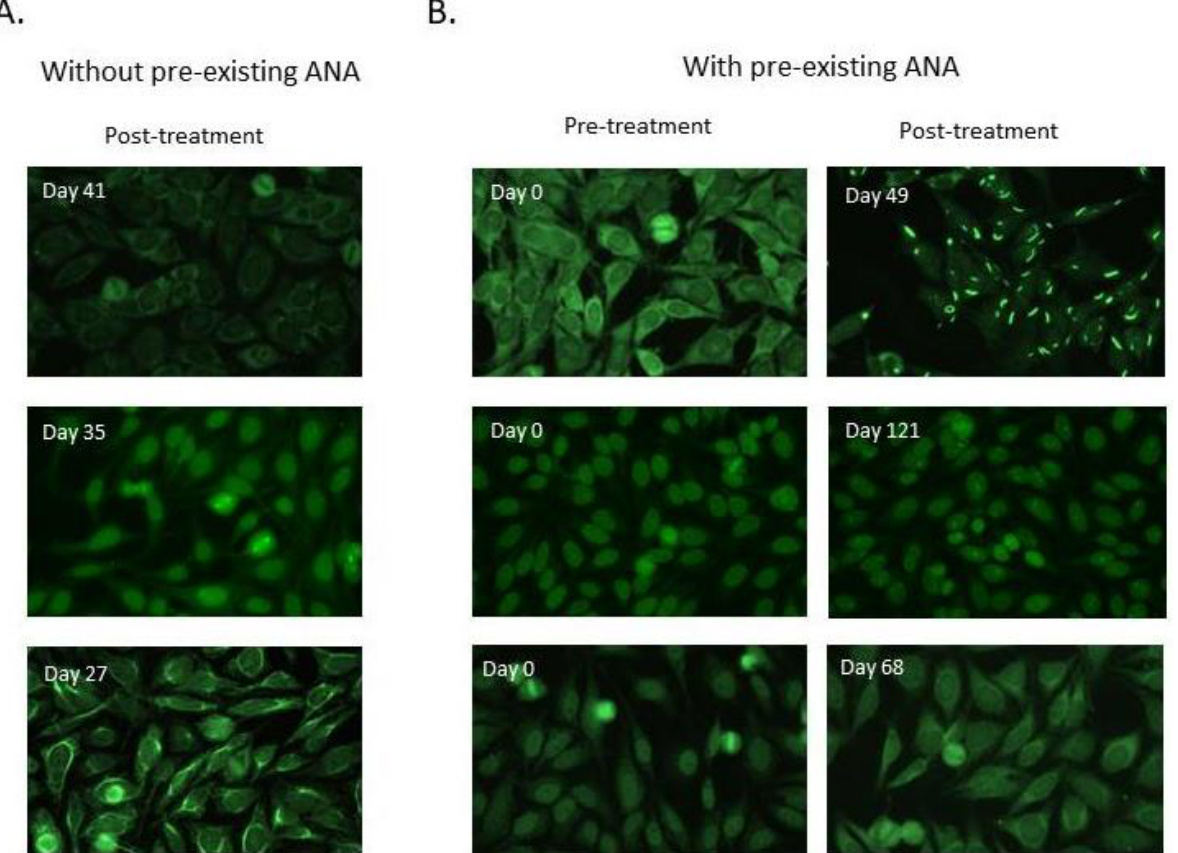
Figure 2. Indirect immunofluorescence images that show differences in ANA patterns in pre- and post-treatment serum samples of patients who developed ANA during ICI treatment. Representative IIF images of pre-treatment and post-treatment serum samples from patients who developed ANA patterns de novo after ICB initiation ( A ) without pre-existing ANA and ( B ) with pre-existing ANA. Days passed after ICI initiation in post-treatment samples are indicated in each image. Negative pre-treatment samples are not represented.